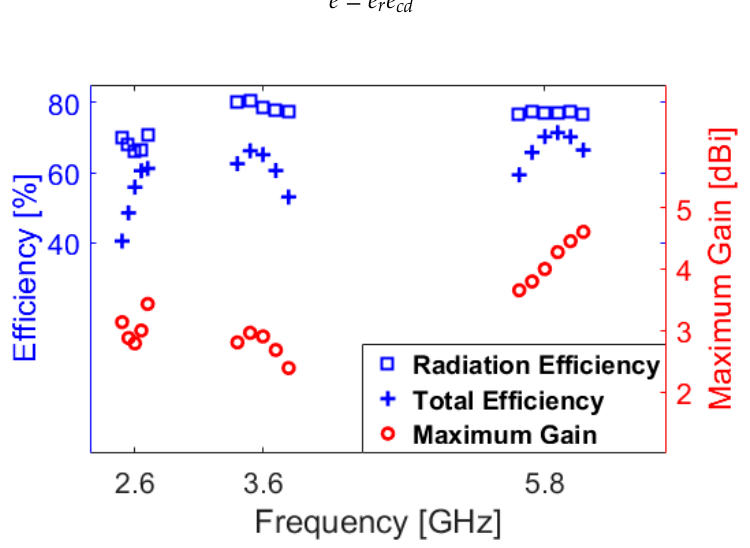
Figure 5. Radiation characteristics of the PIFA element versus its operation bands.